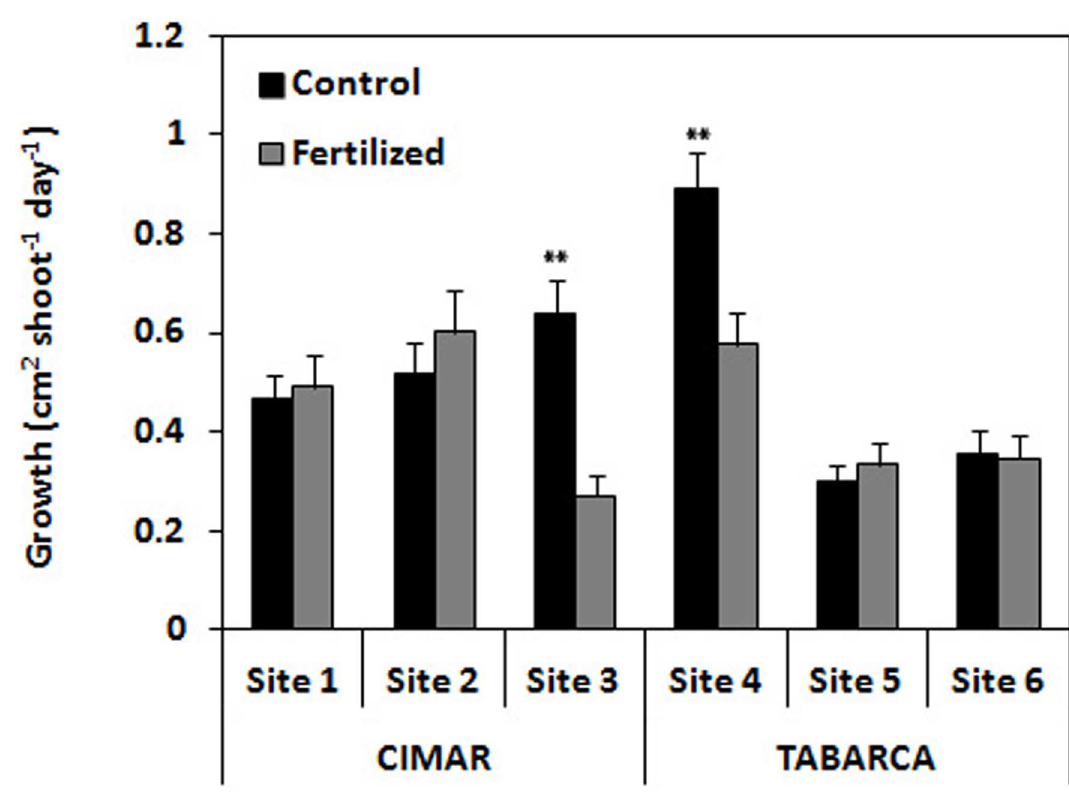
Fig 1. Growth rates recorded in leaves of P . oceanica at CIMAR and Tabarca in the different sites for control vs. fertilized treatments. Mean ± SE. ** p <